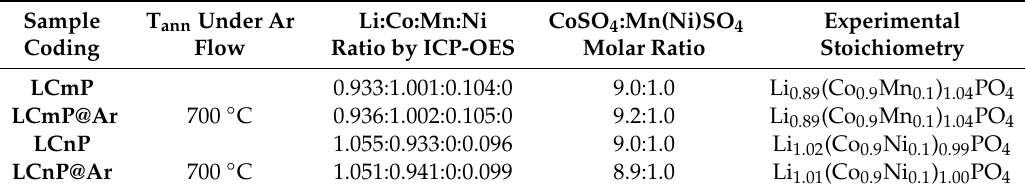
Table 1. Coding and estimated